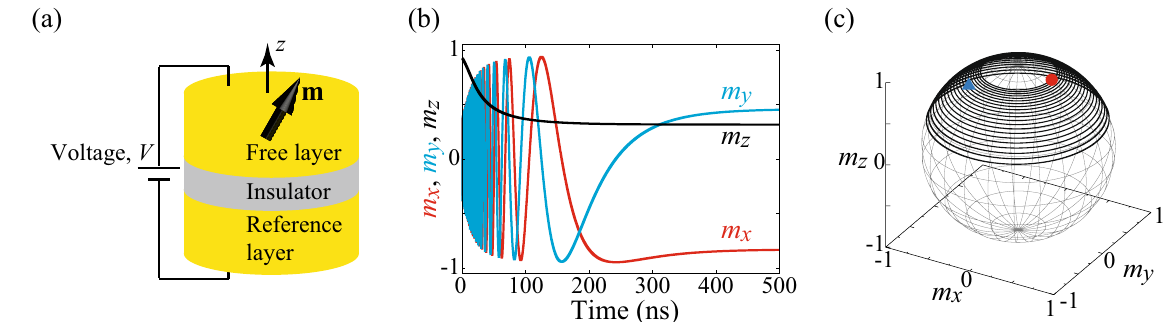
Figure 1. ( a ) Schematic illustration of an MTJ. The unit vector pointing to the magnetization direction in the ferromagnetic free layer is m . The z axis is perpendicular to the film plane. ( b ) An example of the time evolutions of m x (red), m y (blue), and m z (black). ( c ) Trajectory of the relaxation dynamics on a sphere. In ( b , c ), the first order magnetic anisotropy field H K1 is changed from The red circle and blue triangle in ( c ) represent the initial and final states of the